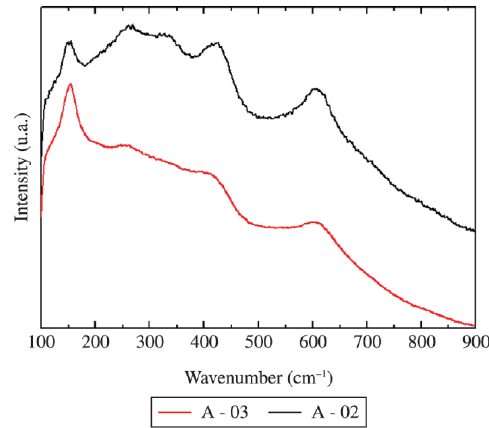
Figure 9. Raman spectra of doble titanium cage film deposited samples in different conditions. The samples A-02 and A-03 were deposited with a treatment time of 2 hours, a gaseous mixture of 06 sccm